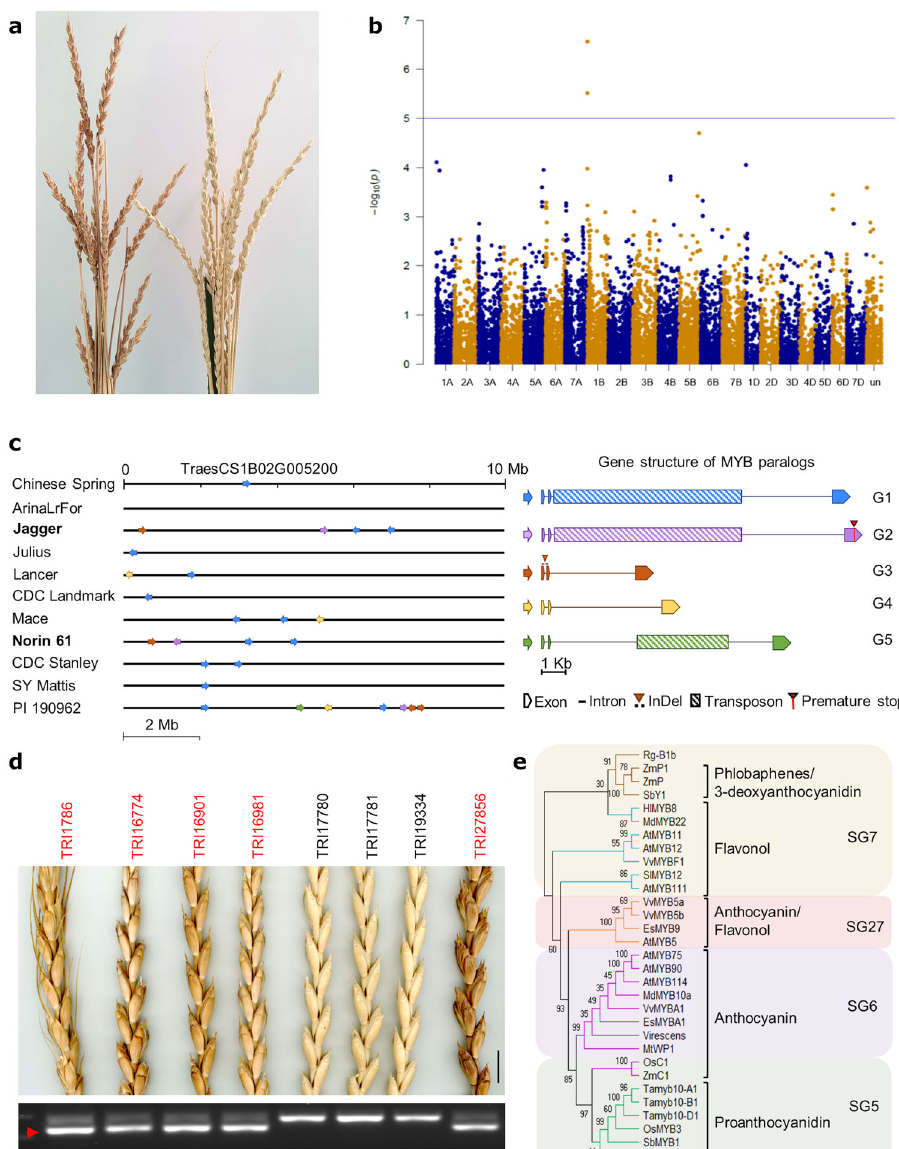
Fig. 3 Haplotype variation at the red glume Rg-B1 locus. a Images of a white glume spelt accession (right) and a red glume spelt accession (left). b Manhattan plot showing a signi fi cant association for glume color at the Rg-B1 locus on chromosome arm 1BS. The physical con fi dence interval spans positions 2.24 – 4.17 Mb in the RefSeq v1.0 assembly of Chinese Spring. The region contains a MYB transcription factor gene (TraesCS1B02G005200). c Copy number and allele variation for the candidate MYB transcription factor gene in ten high-quality wheat assemblies. Shown are the fi rst 10 megabases of chromosome arm 1BS in the ten different wheat assemblies (left). Arrows indicate MYB -like transcription factor genes that are paralogous to TraesCS1B02G005200. Colors refer to one of fi ve different allele groups (G1 – G5) shown on the right. Group 3 is associated with red glumes in bread wheat and spelt. d Haplotype-speci fi c PCR marker for the group 3 alleles. The red arrow points to the 334 bp amplicon speci fi c for the group 3 Rg-B1 alleles. Scale bar = 1 cm. e Phylogenetic analysis of MYB transcription factors regulating the fl avonoid biosynthesis pathway. SG = subgroup based on conserved amino-acid motifs 41 . The speci fi c fl avonoids that are linked to each subgroup are